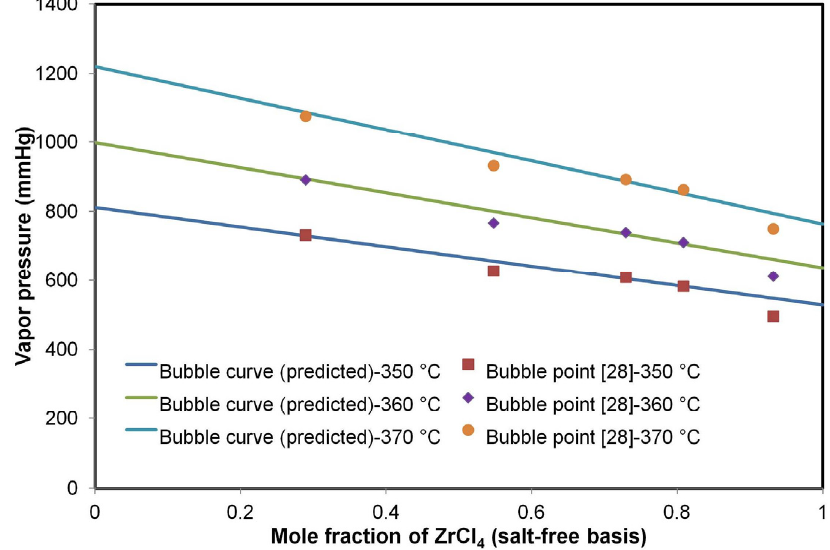
Figure 2. P-x diagram of the molten salt system (34.0% NaCl and KCl (8:29 M); 66.0 mol% ZrCl 4 and HfCl 4 ).